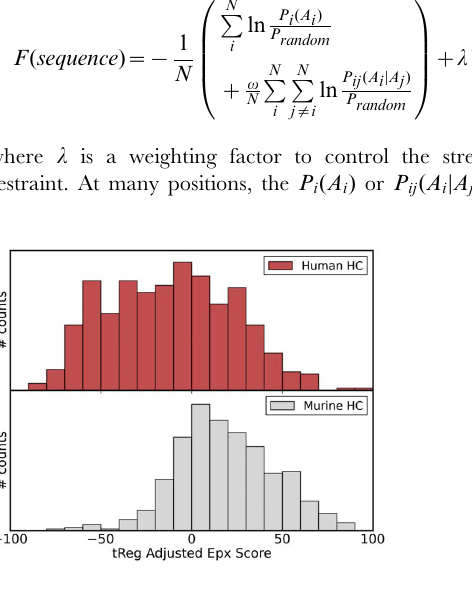
Figure 4. Predicted immunogenicity. Distribution of Epivax Scores for human and murine heavy chain sequences of 500 randomly picked sequences from the Abysis data set are shown. Low Scores indicate a lower risk of